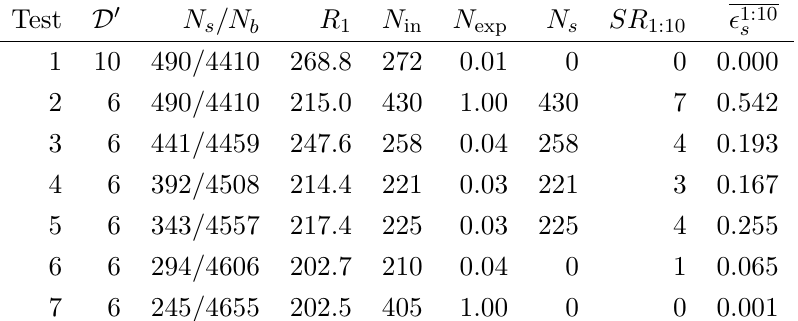
Table 10 . Results of RanBox on a 4900-event sample of fraud detection data, with 10,000 trials. The tests have varying signal contamination and subspace dimensionality D 0 . SR number of signal-rich boxes among the 10 with highest test statistic. See the text for other